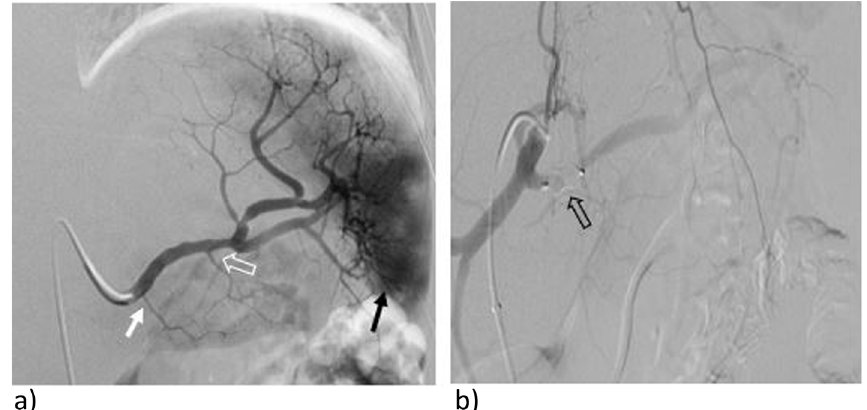
Fig. 3 Embolization technique. A Digital subtraction angiography (DSA) of the splenic artery after selective catheterization with a C2 catheter acquired in the same patient prior to embolization. Region of hyperemia in the lower spleen (solid black arrow) and suspected pseudoaneurysms corresponding to the region of grade IV injury. Note the origin of the dorsal pancreatic artery (solid white arrow) and the greater pancreatic artery (open white arrow). B DSA of the celiac axis following proximal embolization. A vascular plug (open black arrow) has been deployed, covering the origin of the dorsal pancreatic artery and slightly proximal to the origin. There is decreased flow in the splenic artery, without residual hyperemia or